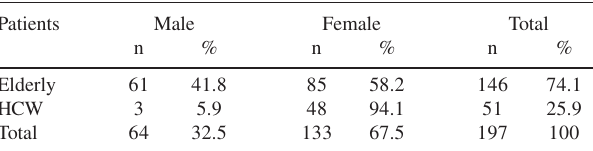
Table 1 - Distribution of individuals vaccinated against